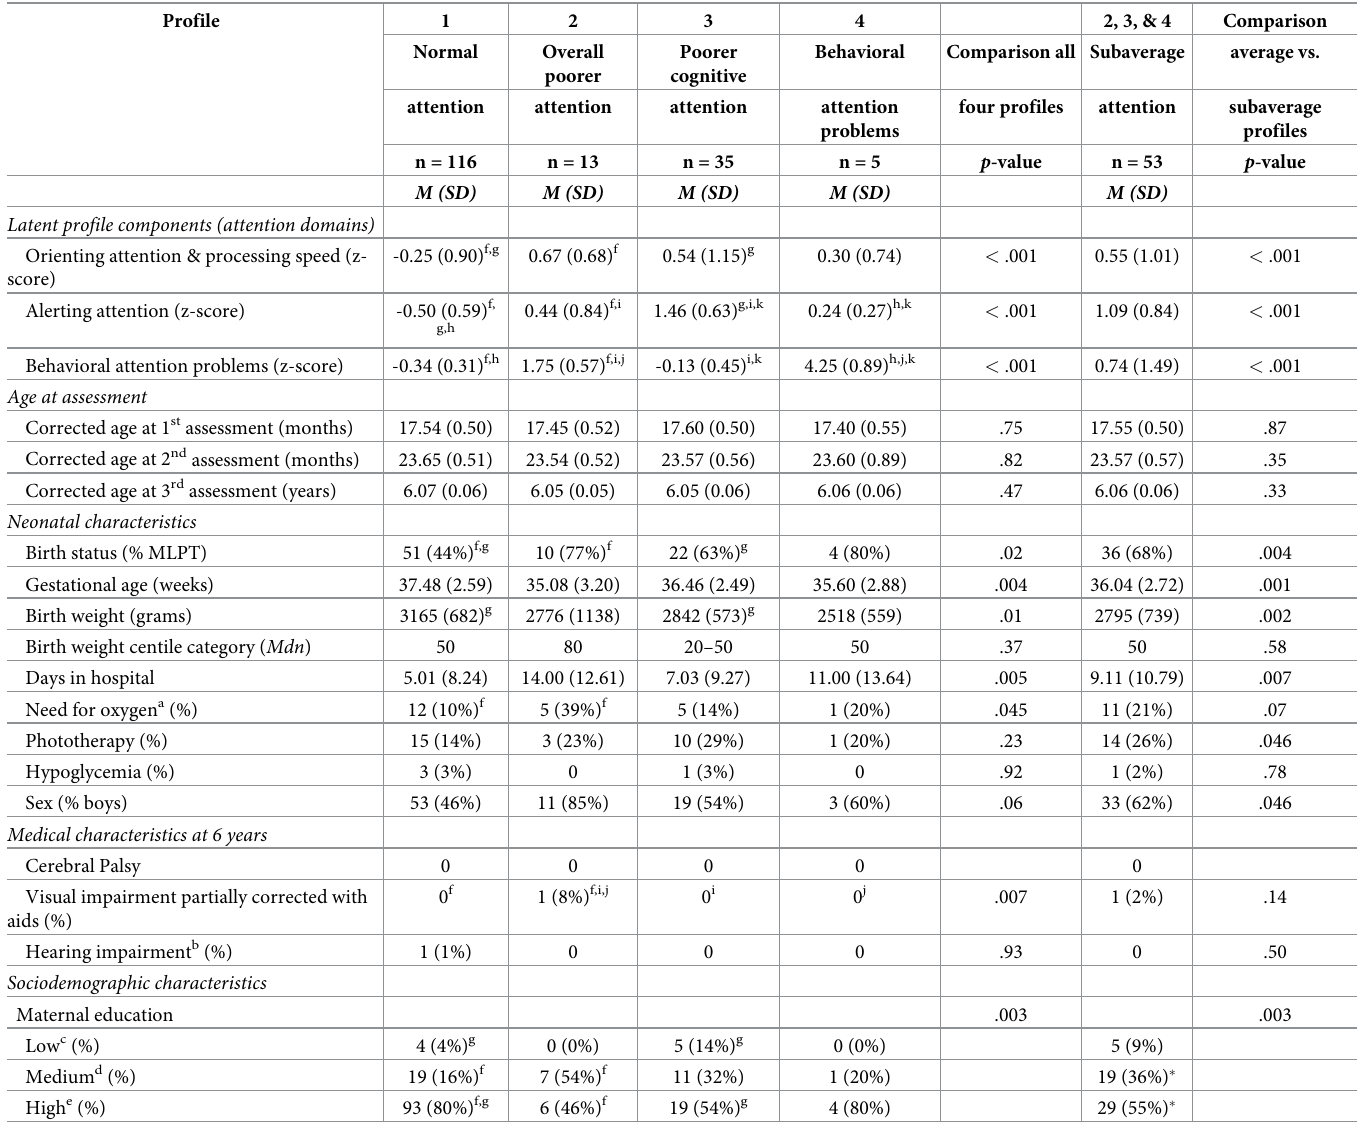
Table 5. Participant characteristics per profile (N =